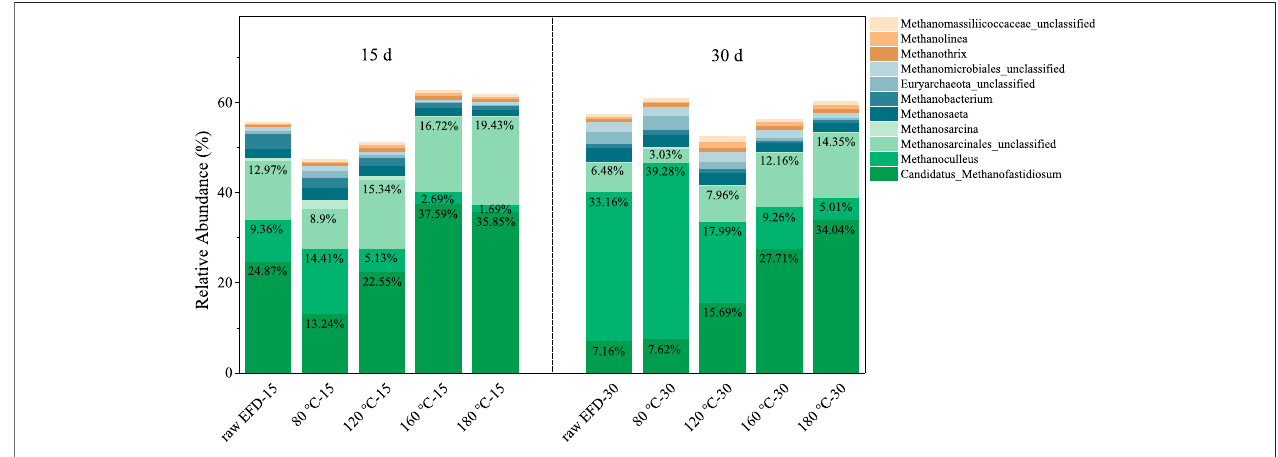
FIGURE 6 | Changes of relative abundance of dominant Archaea genus during AD of the erythromycin fermentation dregs (EFD) with different hydrothermal